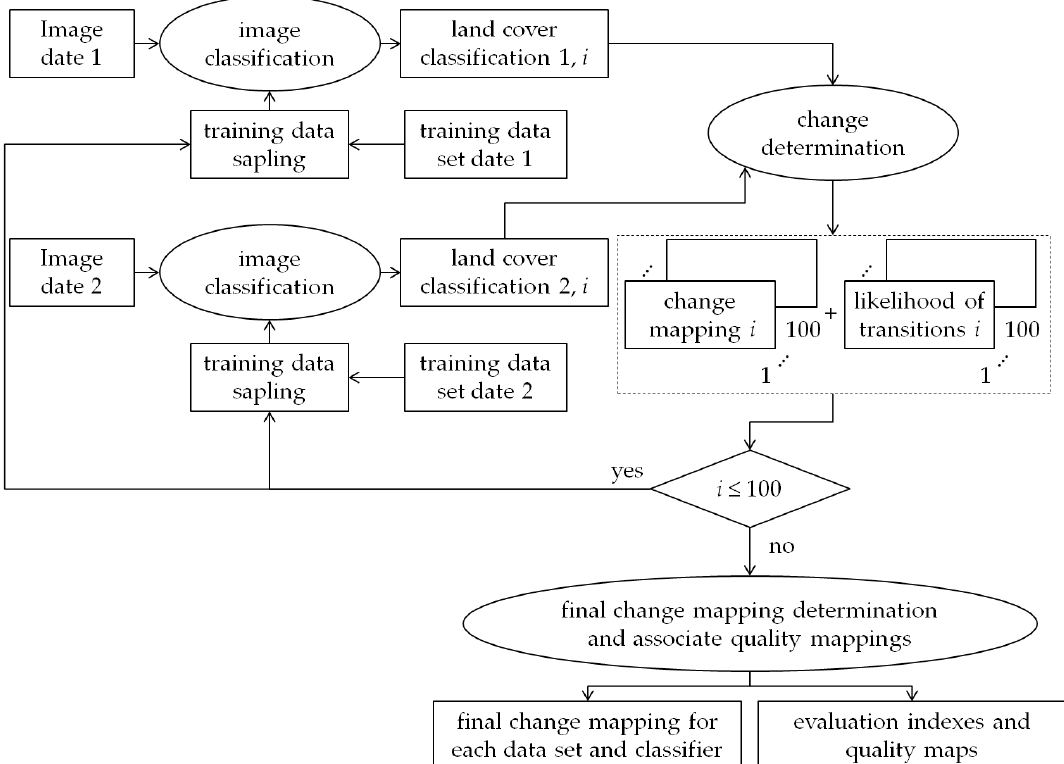
Figure 5. Flowchart of the overall